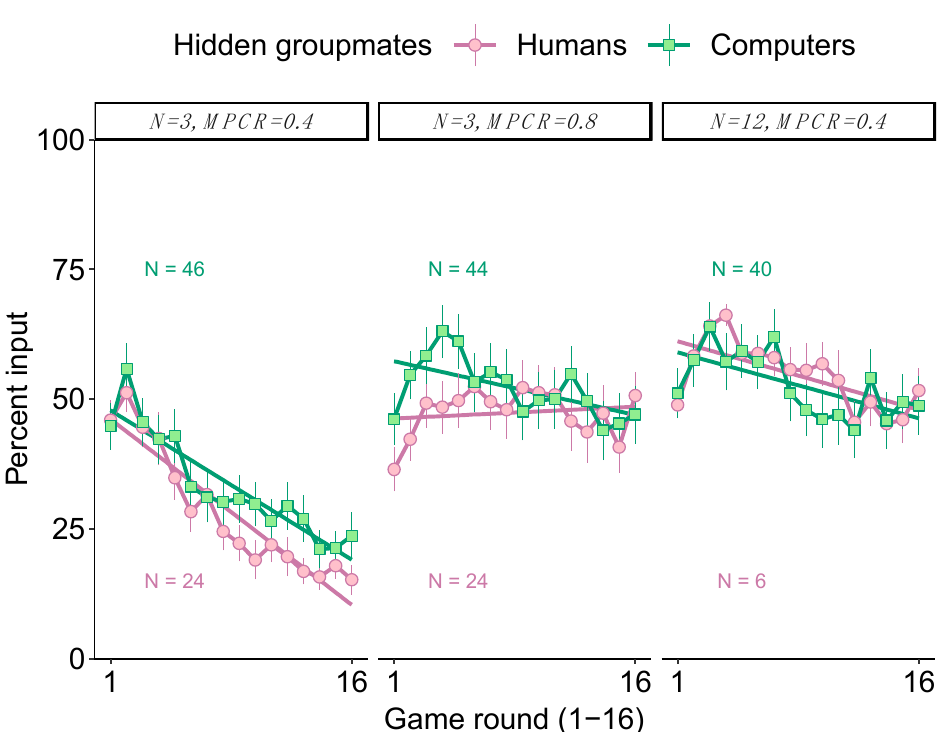
N=3, MPCR=0.4 N=3, MPCR=0.8 N=12, MPCR=0.4